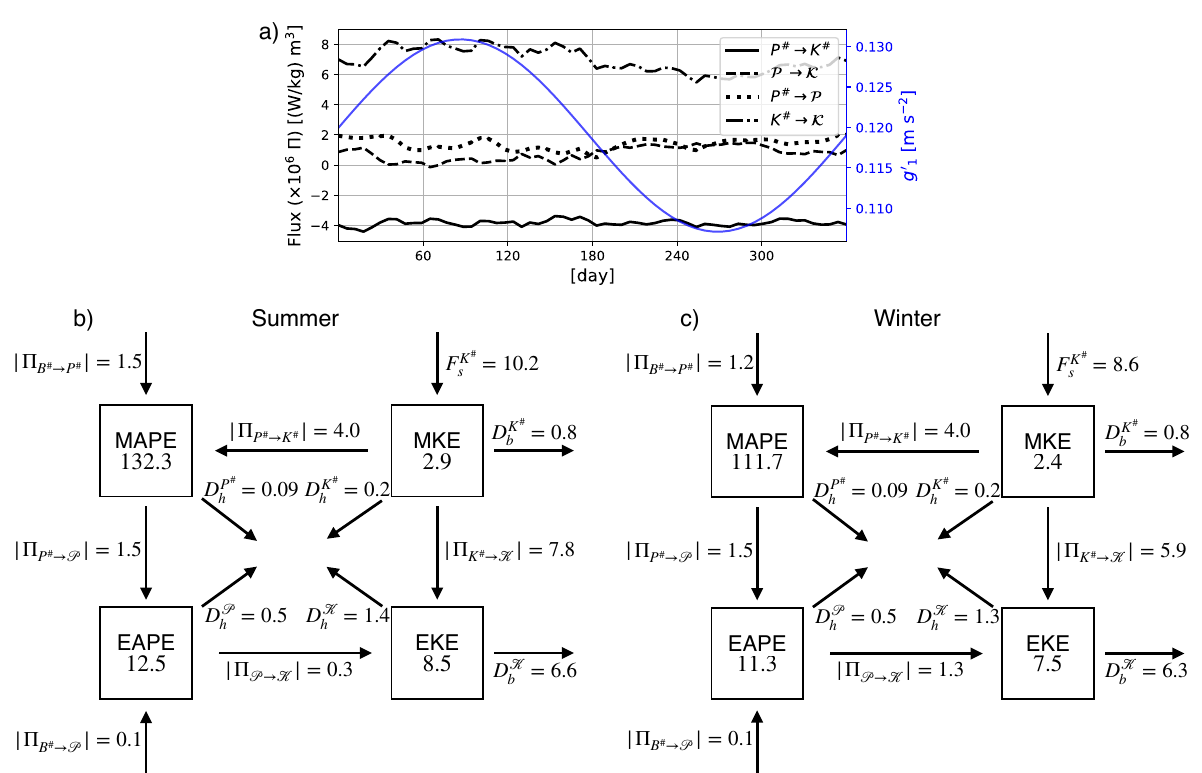
Figure 5. Time series of the seasonal climatology of energy fluxes between the energy reservoirs ( a ). ( b , c ) The LEC diagram for the climatological summer and winter averaged over the last five years of output. The energies are in the units of × 10 13 [(J/kg) m 3 ] and fluxes are in × 10 6 [(W/kg) m 3 ]. The energy exchanges do not exactly cancel out due to each reservoir having temporal